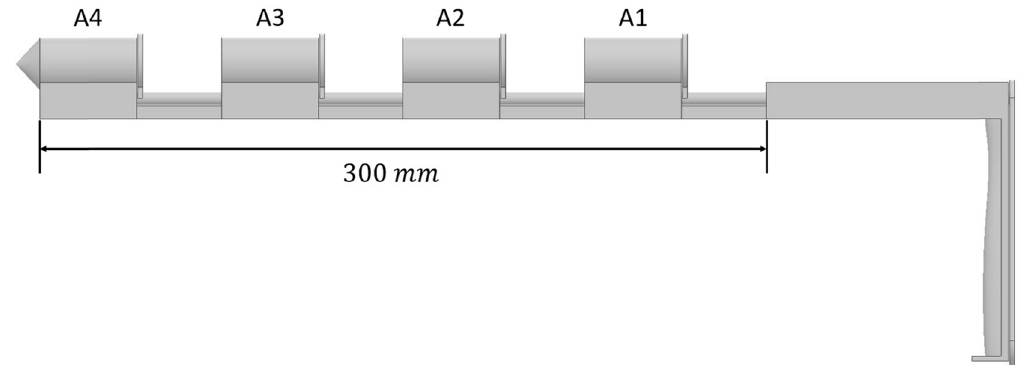
Figure 16: CAD construction of sample lance; left = bottom and right = top.